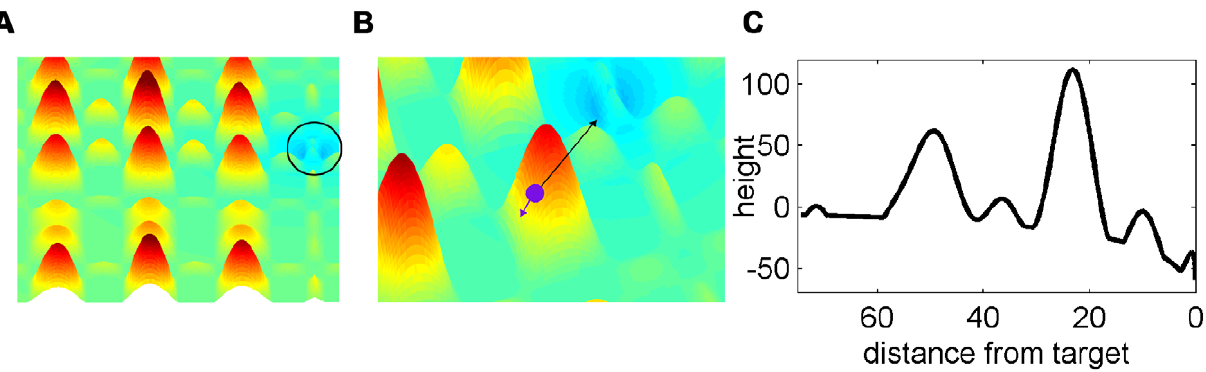
Figure 1. Illustration of the terrain representing the chemical concentration map. A. Overview of the terrain given by cos( b 1 ~ rr 1 z w 1 ) : cos( b 2 ~ rr 2 z w 2 ) z c 1 : K 0 ( ~ rr { ~ xx j j = c 2 ) . B. Illustration of a single agent and the global direction (in black) to the target compared to the local gradient (in purple) of the concentration map. C. Illustration of the terrain height along a straight trajectory from the swarm’s starting position to the target.